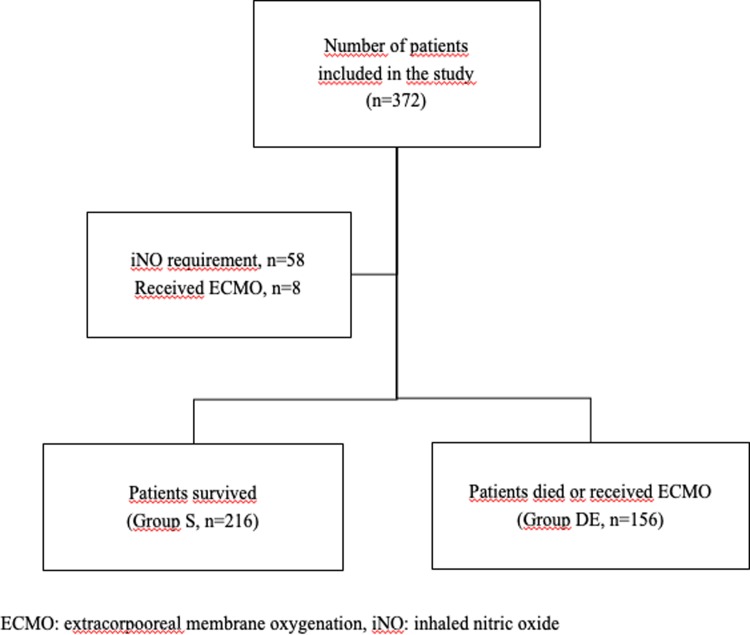
Flow chart of the study.